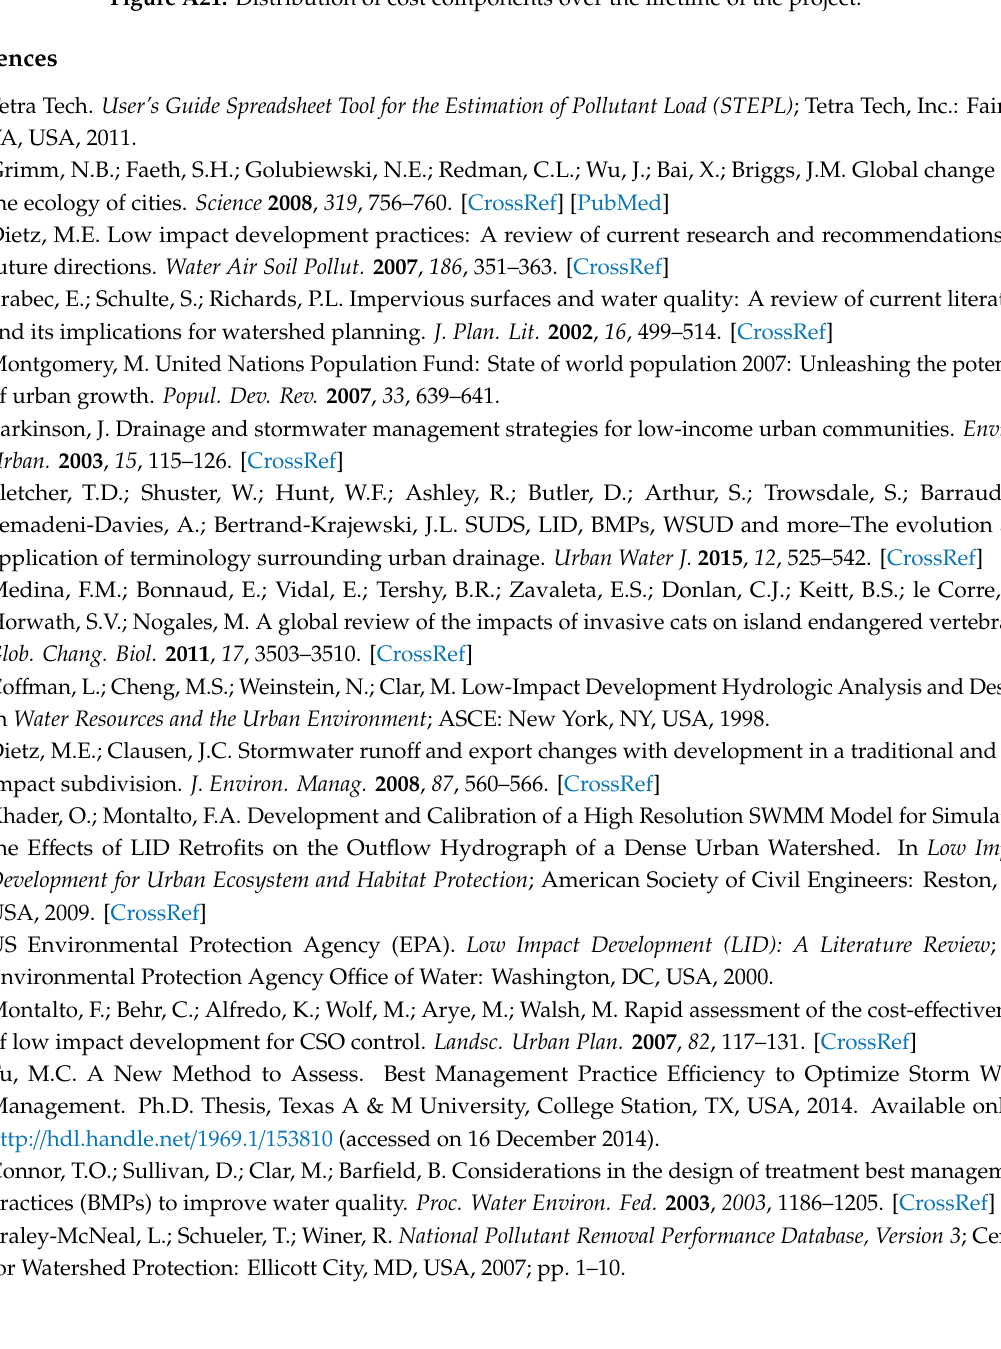
Figure A21. Distribution of cost components over the lifetime of the project